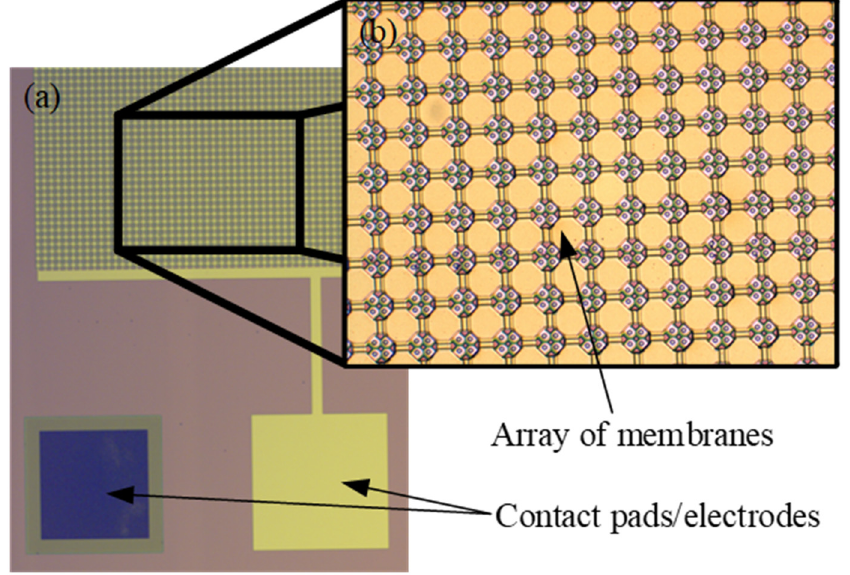
Figure 1. ( a ) Micrograph of capacitive micromachined ultrasound transducer (CMUT) array of membranes with top electrodes and contact pads; ( b ) A close-up micrograph of CMUT membranes fabricated using surface micromachining sacrificial release